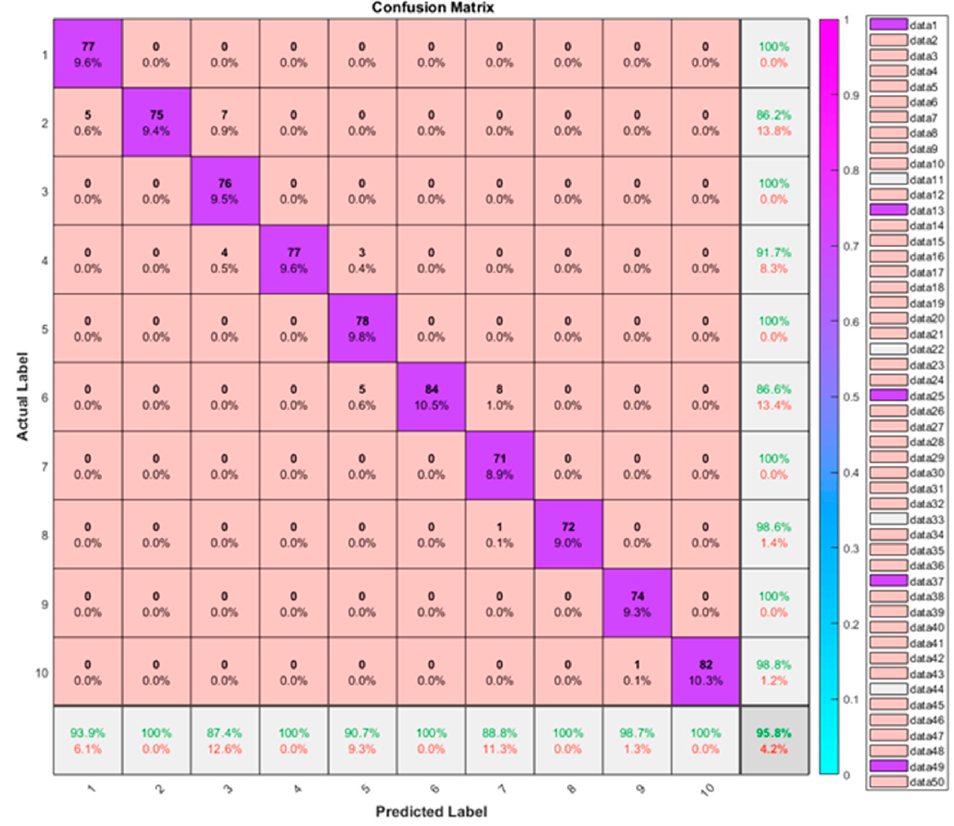
12 of 19 Figure 9. The simulated load (moving): ( a ) moving trainload; and ( b ) time domain force of each of the wheel action points. 3.2. Confusion Matrix Results for the Proposed Method The damage classification results of the proposed method are shown in Figure 10. The confusion matrix of the anticipated approach was carried out to identify each case dataset. The confusion matrix validated the classification results of all the damage cases in an elaborate way that contains the misclassification errors and classification precision as a percentage. The ordinate axis of the confusion matrix was determined as the authentic label of classification, while the horizontal axis predicted the label of classification. The color bar on the right demonstrates the correspondence between colors and numbers be-